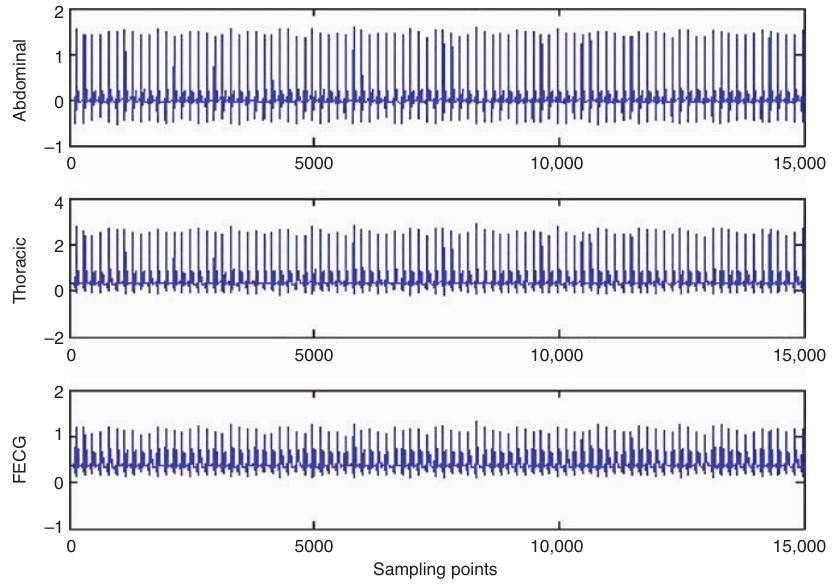
Figure 10: fECG Extraction for Sample Input 5.